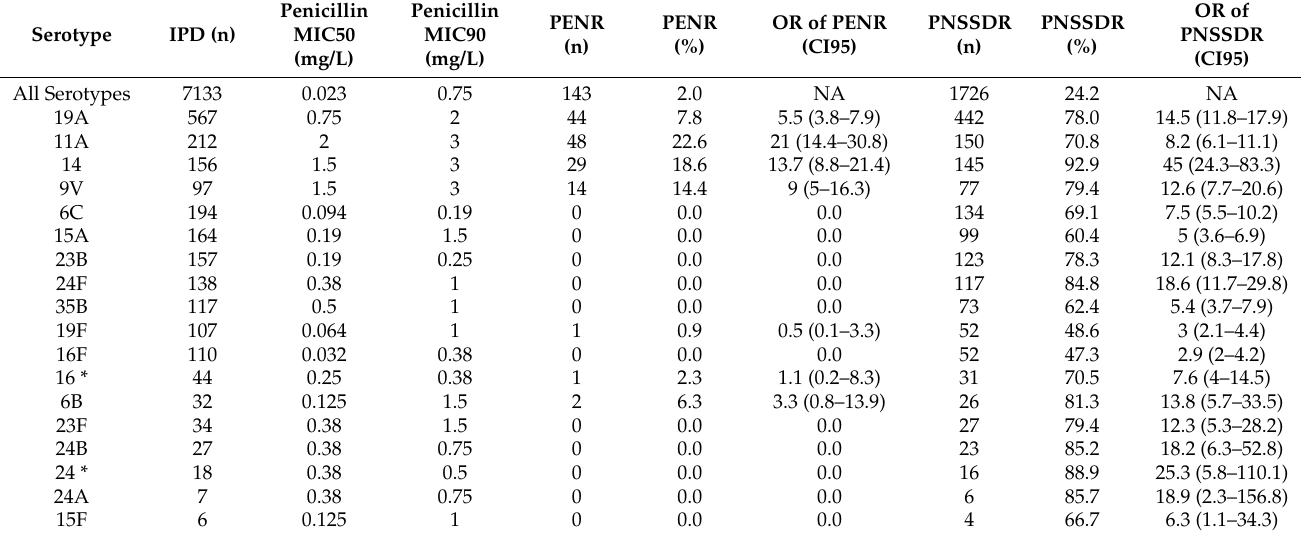
Table 2. Invasive serotypes significantly associated with PENR and/or PNSSDR. (Region of Madrid,